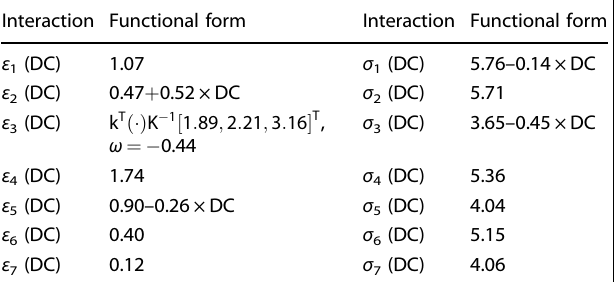
Table 2. Parameters for the simpli fi ed analytical description of all cohesive energies and bead sizes, as shown in Fig.